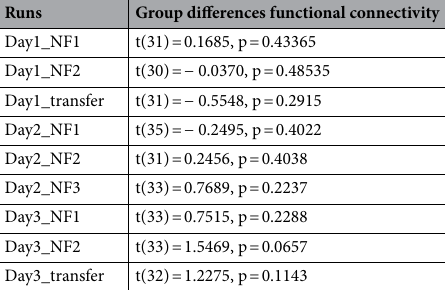
Runs Group differences functional